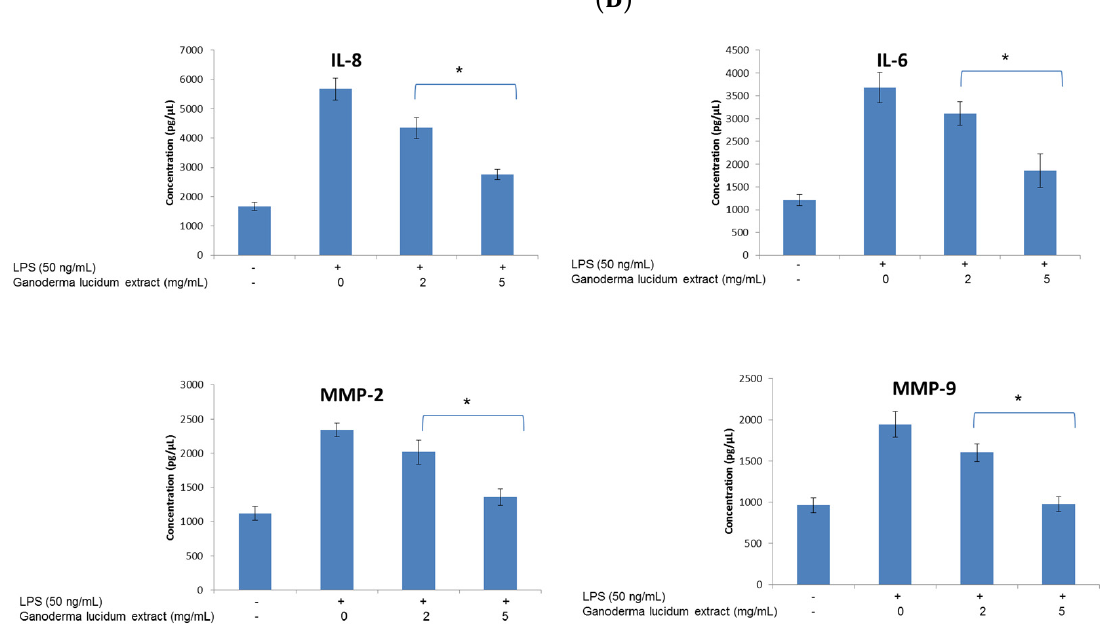
Figure 3. ELISA assay. The effect of DMSO Ganoderma lucidum extract on the concentration of IL-6, IL-8, MMP-2 and MMP-9. ( A ) Triple-negative breast cancer cells were treated with or without 2 and 5 mg/mL solution of DMSO Ganoderma lucidum extract for 30 min before exposure to lipopolysaccharide (50 ng/mL) for 12 h; ( B ) Melanoma cells were treated with or without 2 and 5 mg/mL solution of DMSO Ganoderma lucidum extract for 30 min before exposure to LPS (50 ng/mL) for 12 h. * ( p ≤ 0.01).